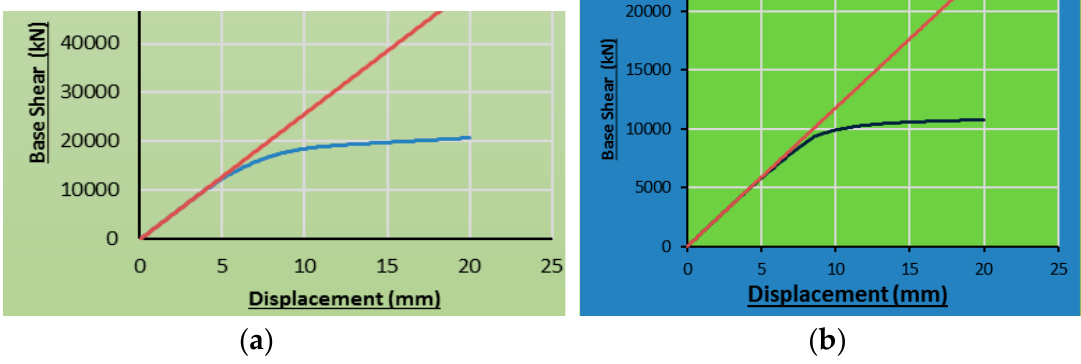
Figure 20. ( a ) Push-over in the East-West direction (Ey), foundation uplift; ( b ) Push-over in the North-South direction (Ex), foundation uplift.